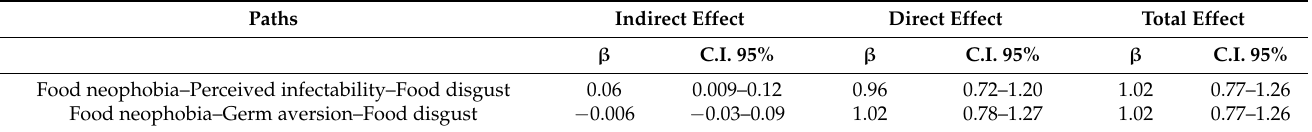
Table 2. Effects of neophobia on food disgust through perceived infectability and germ aversion ( β ). Paths